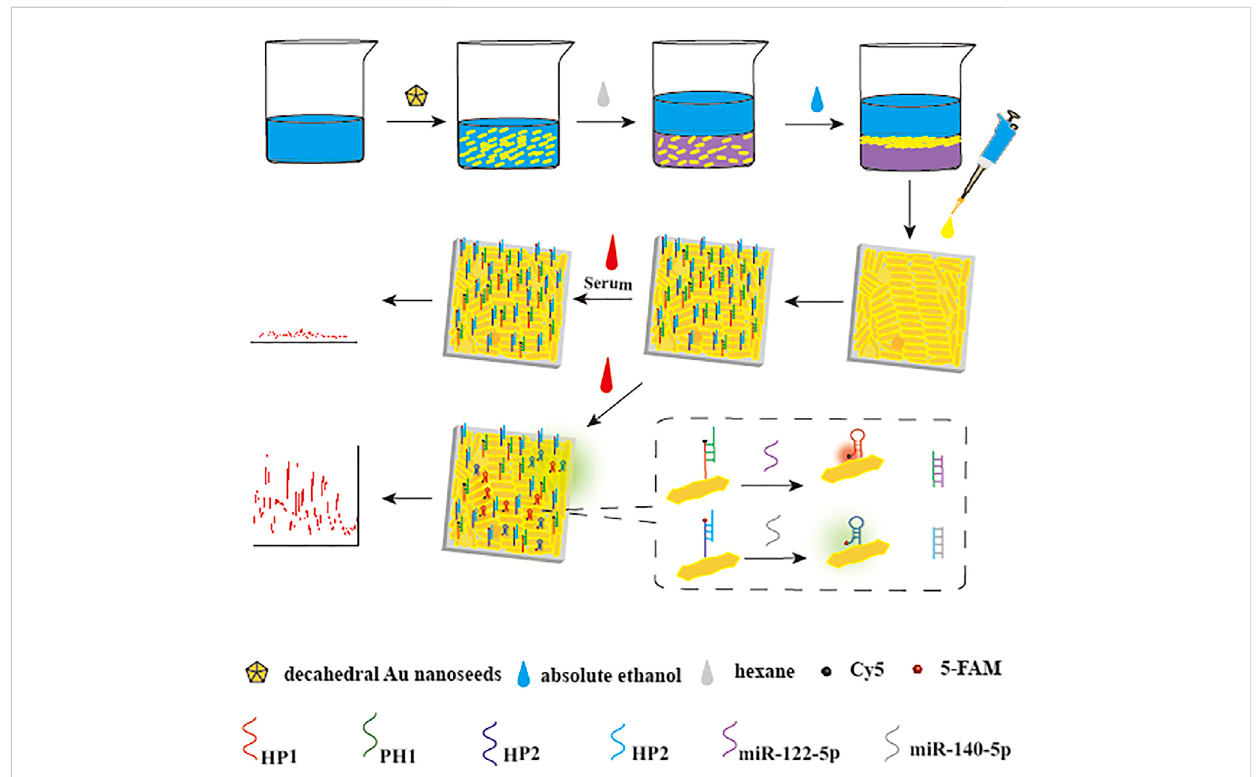
FIGURE 1 Principle of simultaneous detection of target miRNAs. SERS biosensor was fabricated by decorating DS Au nanorods-modi fi ed h-paper with HPs, which were hybridized with PHs and labeled with Raman reporters. In the presence of target miRNAs, the “ inverse Molecular Sentinel ” (iMS) process initiated and induced HPs the conformation change toward the hairpin structure. The hairpin structure of HPs results in the close proximity of Raman reporters to the substrate and a stronger SERS